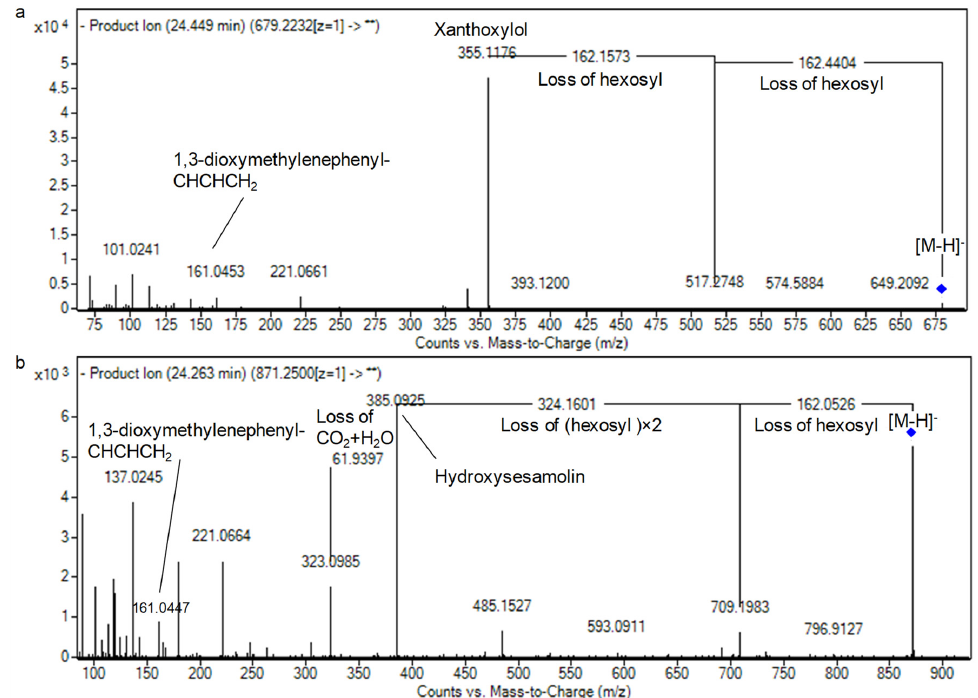
Figure 5. The patterns of fragmentation of ( a ) xanthoxylol dihexoside, and ( b ) hydroxysesamolin trihexoside.